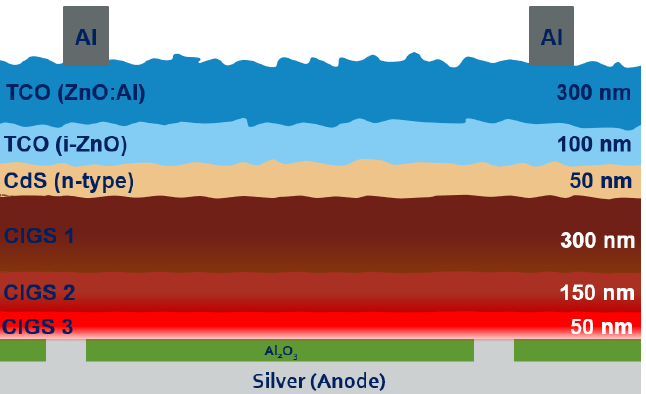
Figure 15. Schematic structure of ultrathin CIGS solar cell with three sub-layers.